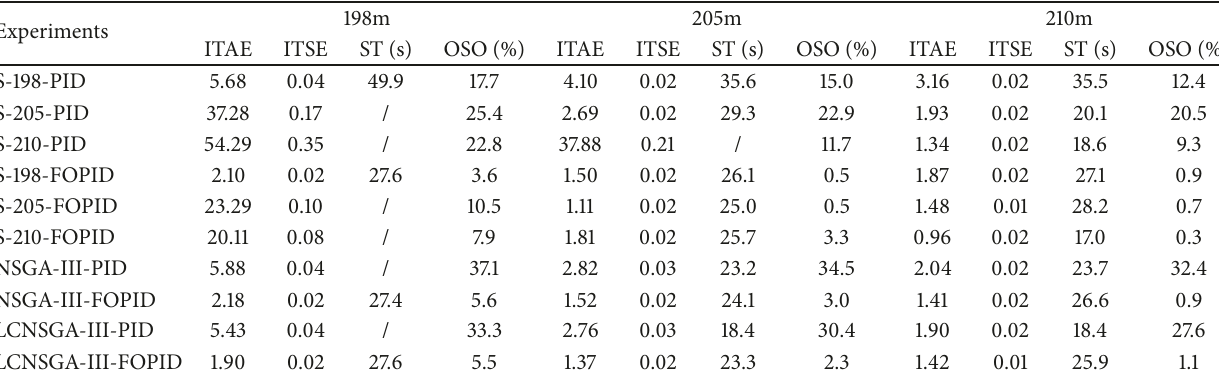
Table 5: Performance indices for nonlinear PTGS using different schemes at different water